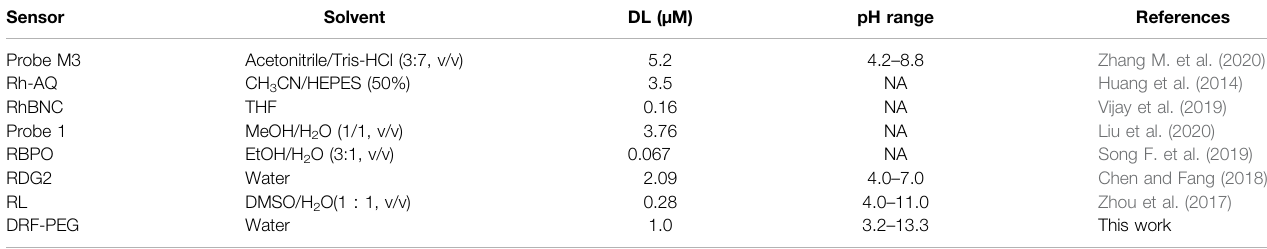
TABLE 1 | Comparison of polymeric sensor containing both PEG chain and rhodamine moiety (DRF-PEG) with other rhodamine-based chemosensors for iron (Fe 3+ ).